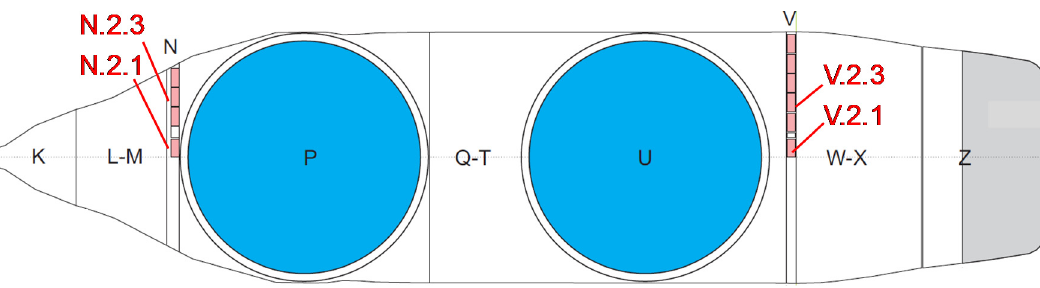
Figure 2. Float-zone crystal ingot Si28-33Pr11: schematic cross section. The measured samples (cubic shape with approx. 500 mg each) bracketing the sphere areas (P and U) are taken from parts N and V.